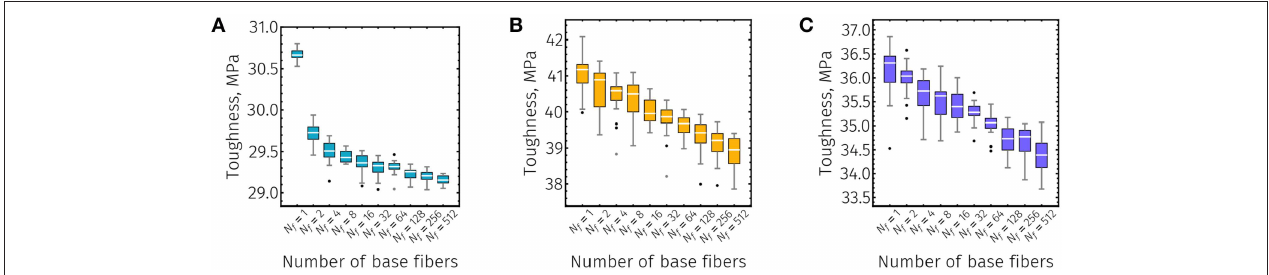
FIGURE 10 | Toughness box-whisker plots (20 independent simulations for each structure size) of CNC films with approximate base fiber lengths (A) L = 50nm, (B) L = 150nm, and (C) L = 300nm. Number of fibers ( N f ) refers to number of CNC fibers in series within the simulation volume and scales linearly with simulation size along the direction of loading. White horizontal lines, colored box, gray vertical lines, and black dots indicate the median, interquantile range (IQR) between 3rd and 1st quantiles, range (of all data within ± 1.5 × IQR), and outliers (points outside the range),